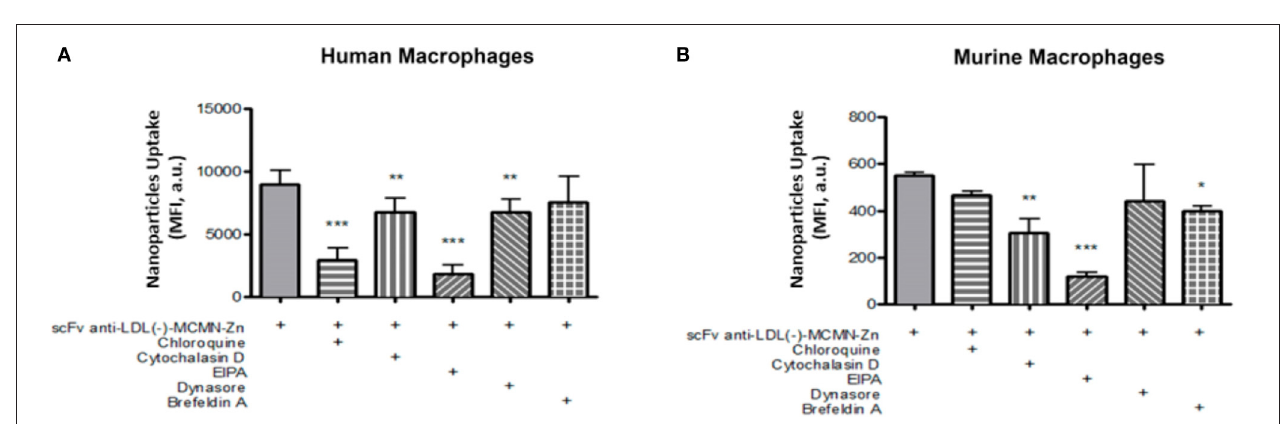
FIGURE 3 | Endocytosis mechanisms involved in the internalization of the scFv-anti-LDL(-)-MCMN-Zn nanoformulation by human and murine primary macrophages. Flow cytometry measurements data from (A) human and (B) murine macrophages treated with 10 4 particles/mL of scFv-anti-LDL(-)-MCMN-Zn nanoformulation (containing 6.25 µ g/mL of scFv) of scFv-anti-LDL(-)-MCMN-Zn nanoformulation for 3h, after 1h incubation with 50 µ M Chloroquine, 40 µ M Cytochalasin D, 50 µ M EIPA [5-(N-Ethyl-N-isopropyl) amiloride], 80 µ M Dynasore, or 1 µ M Brefeldin A. Data from three independent experiments, performed in triplicate, are expressed as the means ± SD; *** p < 0.001, ** p < 0.01 and * p < 0.05 compared with scFv-anti-LDL(-)-MCMN-Zn nanoformulation without any inhibitor; ANOVA followed by the Tukey-Kramer’s